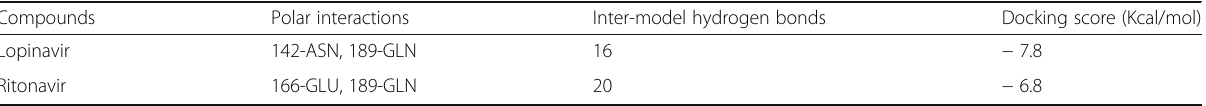
Table 6 The amino acid residues involved in polar interaction, the number of inter-model hydrogen bonds and the docking score of lopinavir and ritonavir upon binding to the 3D PDB download of the SARS-CoV main proteinase (PDB 6m2n)